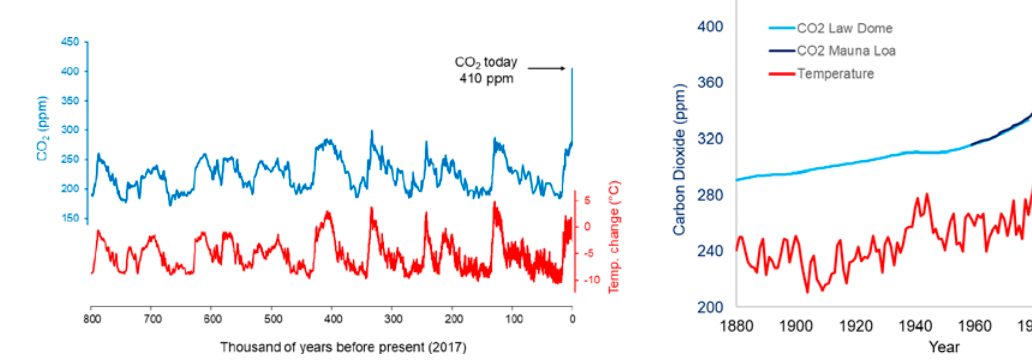
Figure 1. Correlation between CO 2 concentration 1 in the atmos- phere and Earth’s temperature 2 over the last 800,000 years. Tem- perature change is the difference from the average of the last 1000 years.